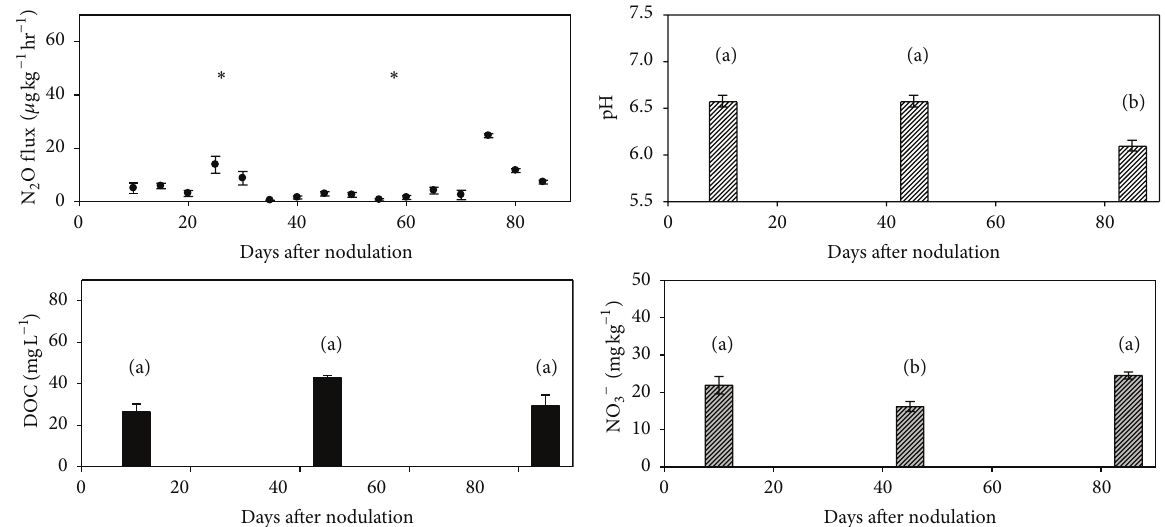
Figure 3: Temporal dynamics of N 2 O flux ( 𝜇 gkg −1 hr −1 ), soil pH, DOC (mgL −1 ), and NO 3− -N (mgkg −1 ) in the control treatment. Different lower case letters indicate a statistically significant difference at 𝛼 = 0.05. ∗ Symbol indicates the application of mineral N fertilizer. Means of 3 replicates with standard